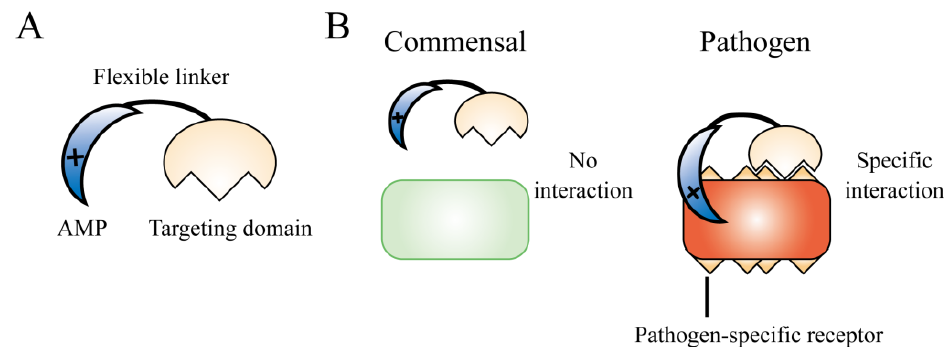
Figure 5. Specifically targeted antimicrobial peptide (STAMP) technology. ( A ) Overview of the STAMP technology. STAMPs are composed of two domains, namely, an AMP domain and a targeting domain. ( B ) A schematic of the selective activity against pathogens. The STAMP accumulates around the targeted pathogenic cells and kills